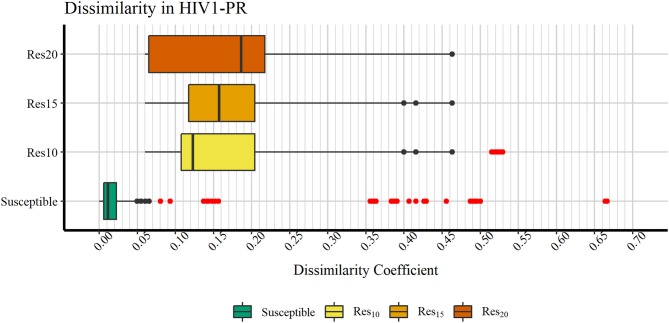
Boxplot representation of dissimilarity coefficients obtained for the HIVDB datasets. The maximum value reported is ~0.667. Outliers are marked in red. Represented datasets: [Susceptible] (green); [Res10] (yellow); [Res15] (orange); [Res20] (dark orange).